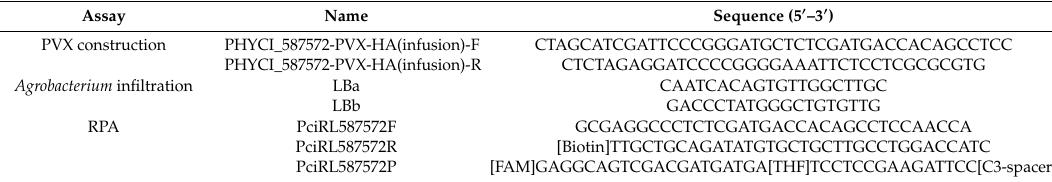
Table 2. Primers used in the construction of binary potato virus X (PVX) vectors,